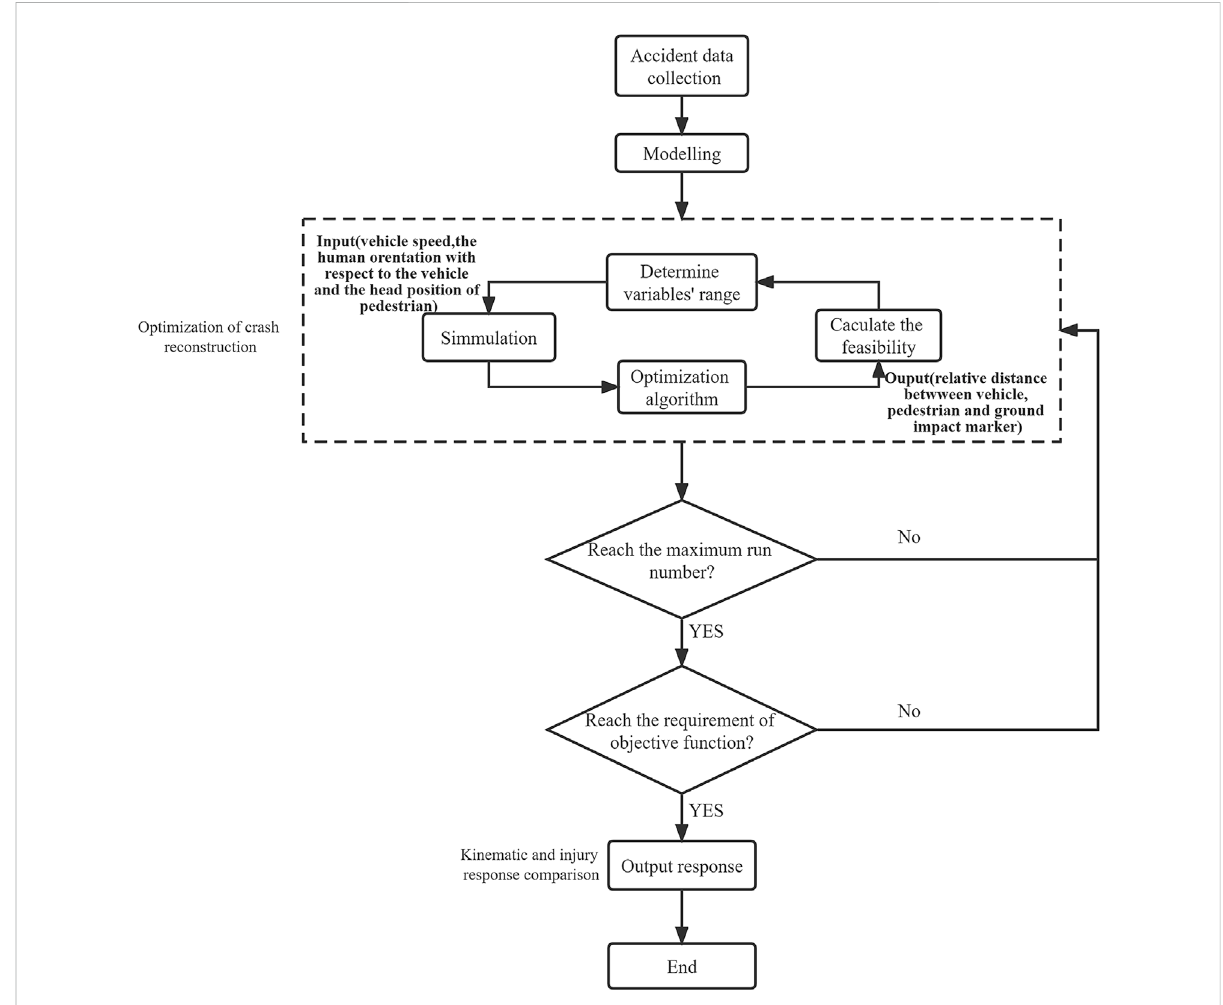
FIGURE 1 Work fl ow of traf fi c accident reconstruction and